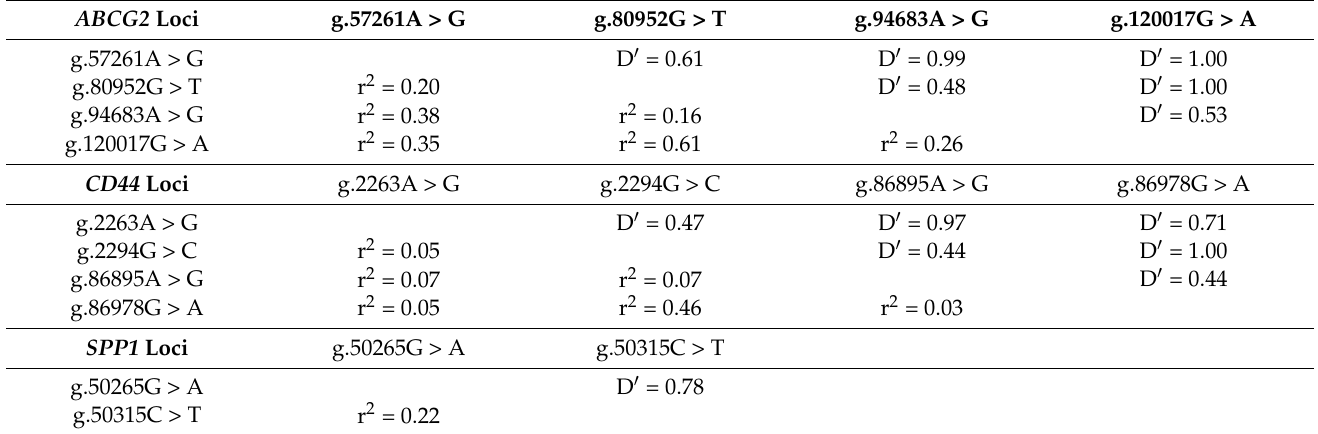
Table 2. The estimated values of LD analysis between mutation sites within the ABCG2 , CD44 , SPP1 genes.